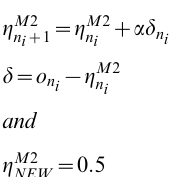
M2: Rescorla-Wagner without generalization. To assess